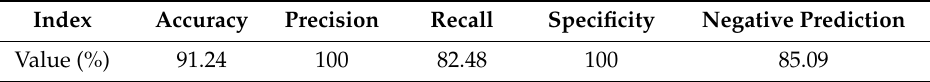
Table 3. Forecast evaluation index